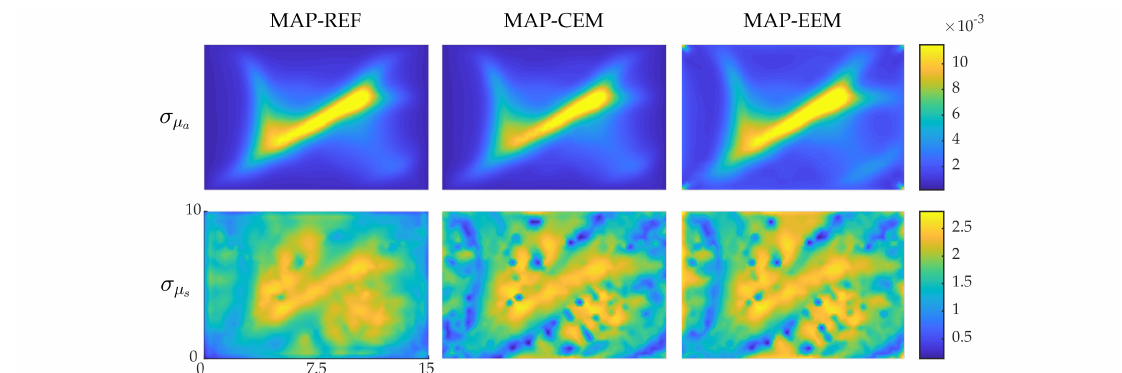
Figure 6. Standard deviations of the posterior distribution approximation of the simulations with blood-vessel-mimicking inclusions. Standard deviations of MAP-REF reconstructions ( first column ), MAP-CEM reconstructions ( second column ) and MAP-EEM reconstructions ( third column ). The first row presents the results of the absorption coefficients and the second row the scattering coefficients. The units of axes are in mm and colorbars in mm − 1